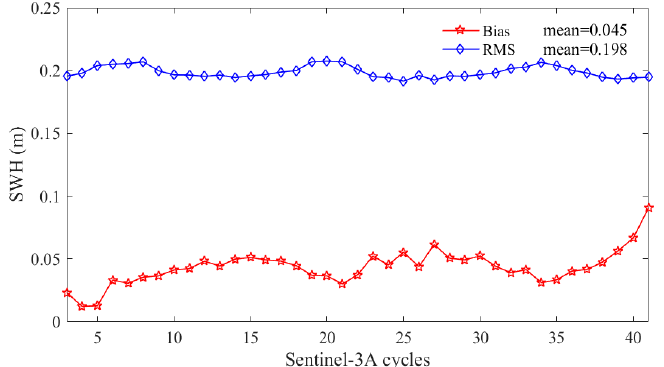
Figure 11. Cycle by cycle biases and RMSEs of SWH differences between SAR and PLRM mode.